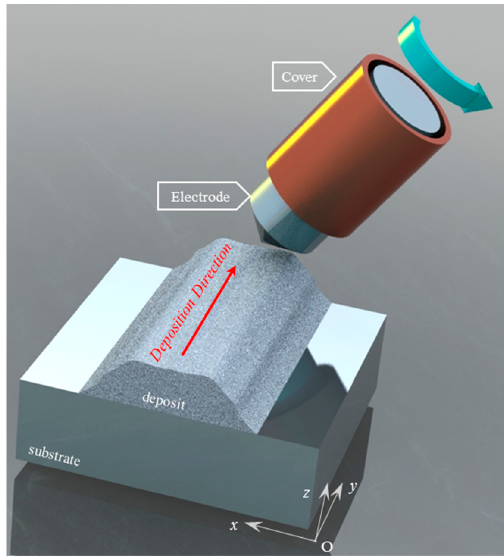
Figure 1. Representation of the ESD process.